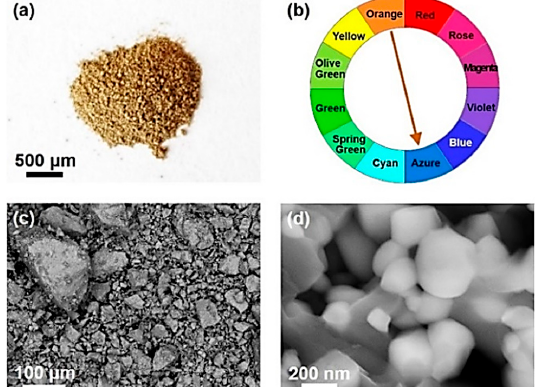
Figure 5. ( a ) Powder image, ( b ) Itten color wheel corresponding to orange color of powder, and ( c , d ) micrographs of powders by scanning electron microscopy for dual-phase high-entropy oxide TiZrHfNbTaO 11 , synthesized by high-pressure torsion and high-temperature oxidation, reproduced from [76], with permission from ROYAL SOCIETY OF CHEMISTRY, 2020.